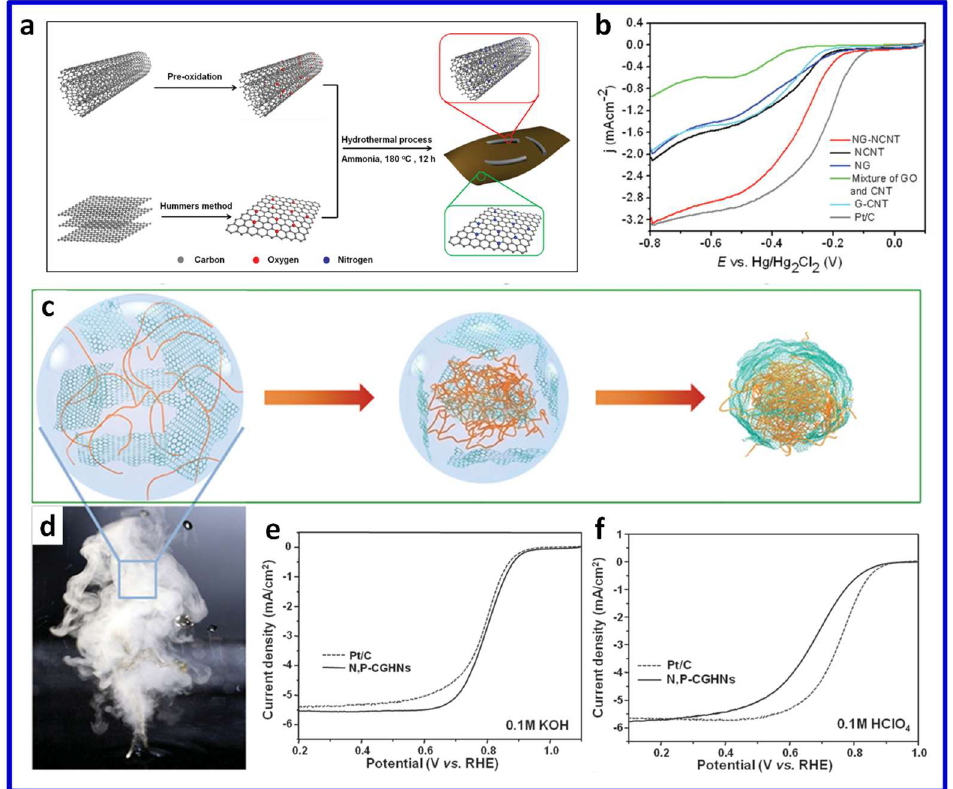
Figure 10. ( a ) Schematic illustration of the preparation of the NG-NCNT nanocomposites; ( b ) RDE voltammograms in O 2 -saturated 0.1 M KOH solution at room temperature (rotation speed 1600 rpm, sweep rate 20 mV·s −1 ) for the NG-NCNT, NCNT, NG, G-CNT, Pt/C and directly mixed product of GO and OCNT. Reproduced from [119], Copyright 2013, Wiley. ( c ) Schematic illustration of the process for co-assembling carbon nanotubes and graphene into hybrid nanospheres in rapidly evaporating aerosol droplets; ( d ) A photograph of the ultrasonic fountain and mist generated by a high-frequency ultrasound (1.7 MHz) from an aqueous dispersion containing oxidized carbon nanotubes and graphene oxides; ( e ) LSV curves of N, P-CGHNs and Pt/C in O 2 -saturated 0.1 M KOH; ( f ) LSV curves of N, P-CGHNs and Pt/C in O 2 -saturated 0.1 M HClO 4 . Reproduced from [125], Copyright 2016, Wiley.